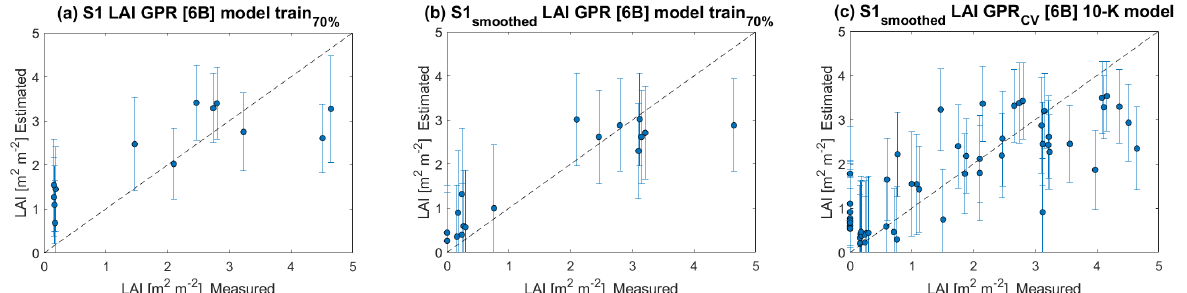
Figure 6. Measured vs. estimated winter wheat LAI along 1:1-line, including uncertainty intervals. ( a ) LAI model estimates using multiple local incidence angles of S1 non-smoothed time-series data; ( b ) LAI model estimates using S1 smoothed time-series data at multiple local incidence angle acquisi- tions and 70% of the data for model training; ( c ) LAI model estimates using S1 smoothed time-series data at multiple local incidence angle acquisitions and 10-fold CV for model training.